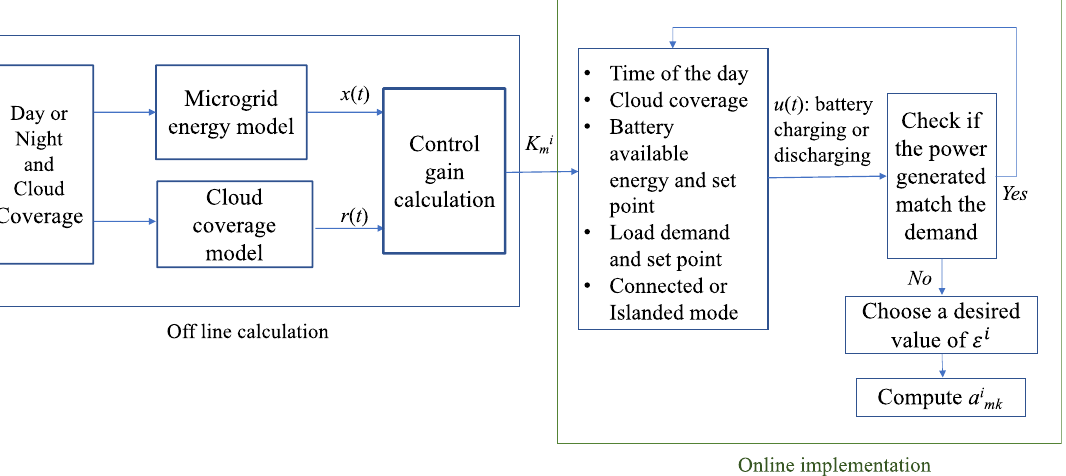
Figure 2. Procedure for calculating the optimal regulator gain and coefficients 𝑎 𝑚𝑘𝑖 .